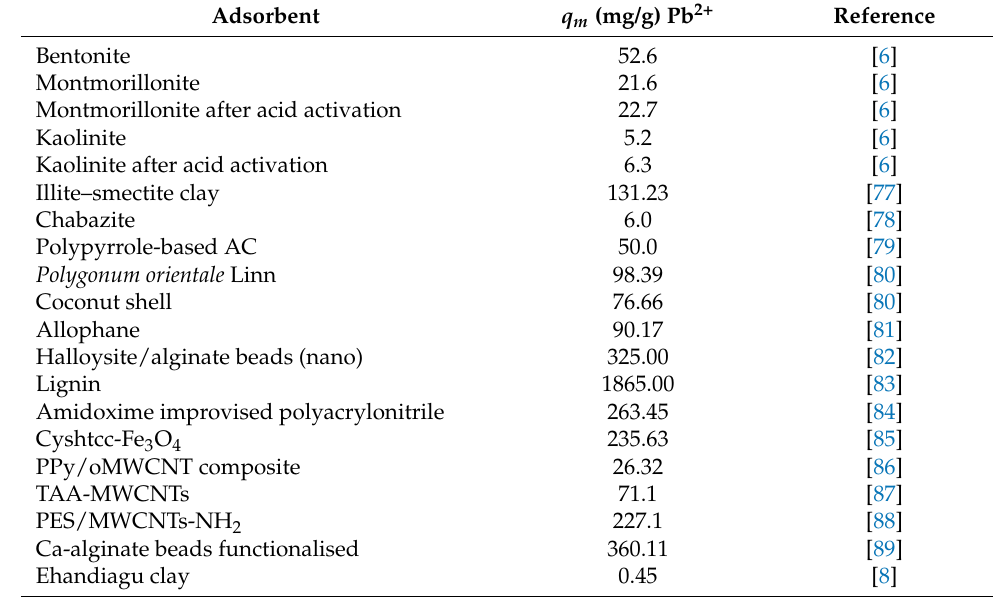
Table 4. Comparative adsorption capacities ( q m ) for Pb 2+ uptake of various